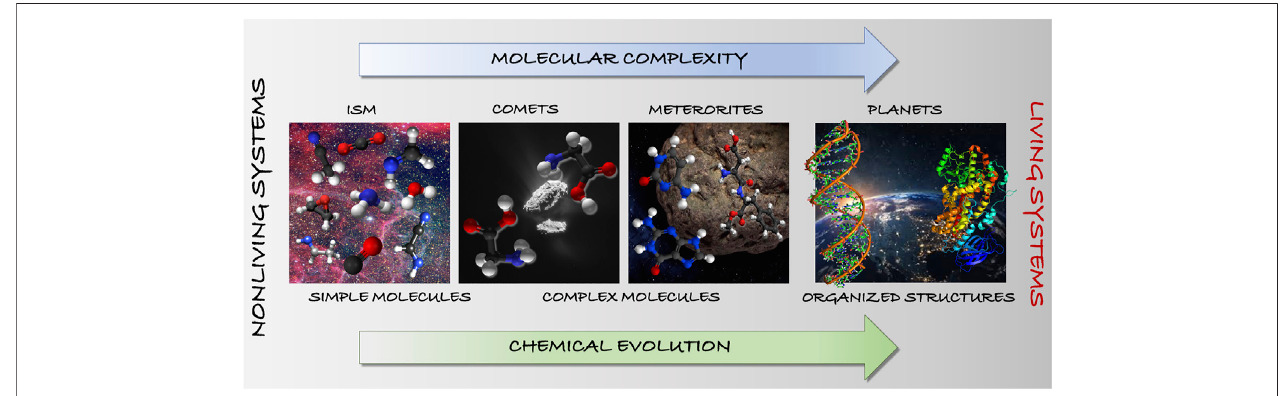
FIGURE 1 | Chemical evolution in terms of molecular and astronomical complexity: from simple to complex molecules toward pre-biological and biological systems.